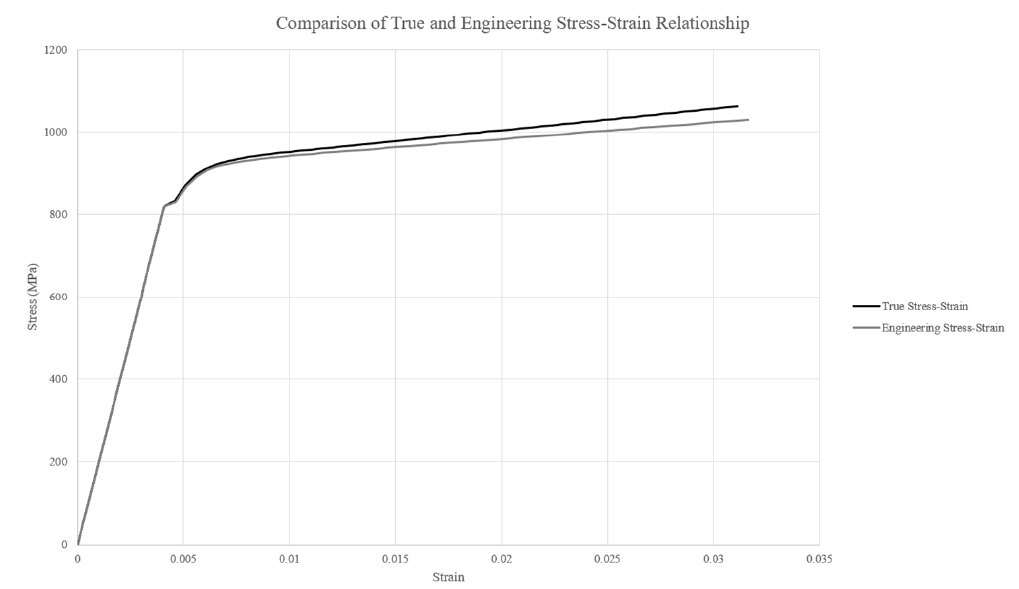
Figure 3. Engineering vs. true stress–strain curve.